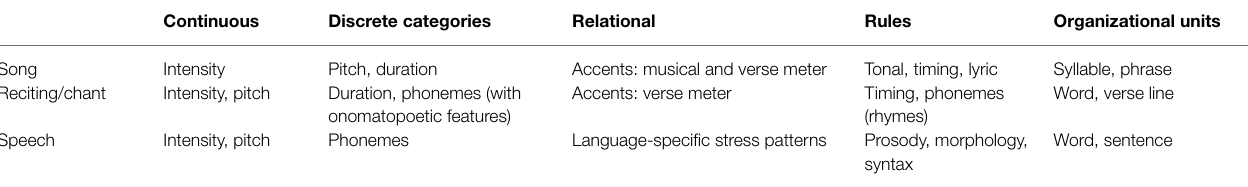
TABLE 1 | Syllables and their properties are differently organized in song, reciting poems, and in speech.